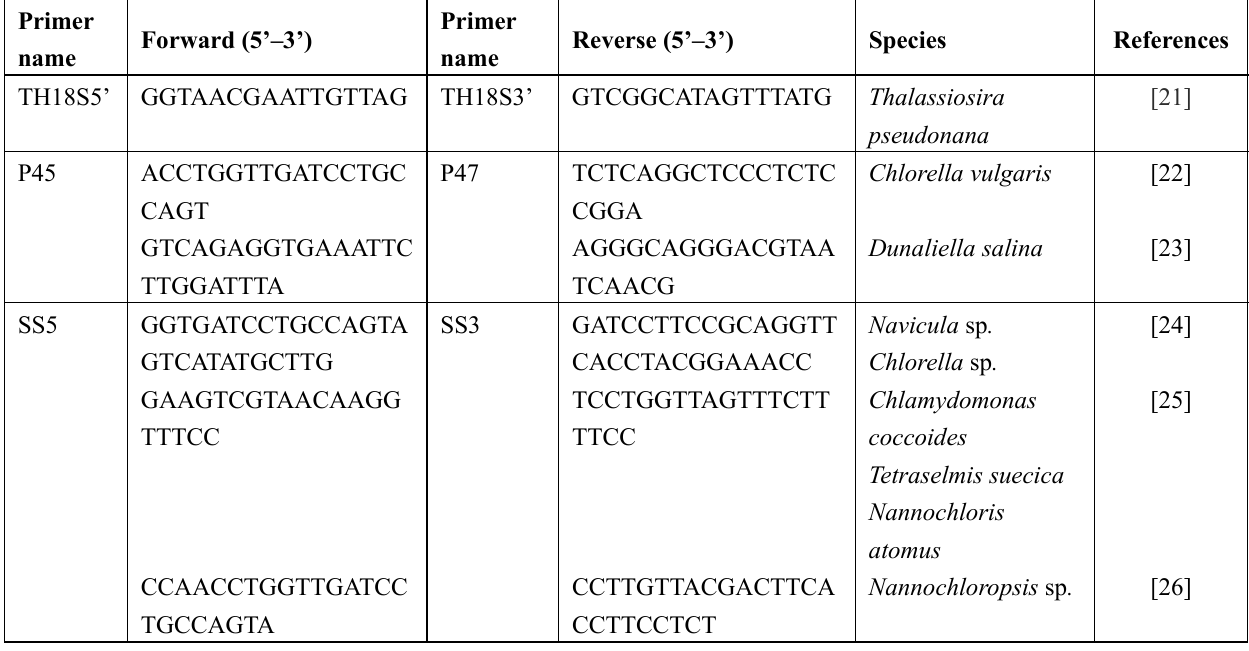
Table 1. Examples of 18S rDNA primers for the identification of microalgae by